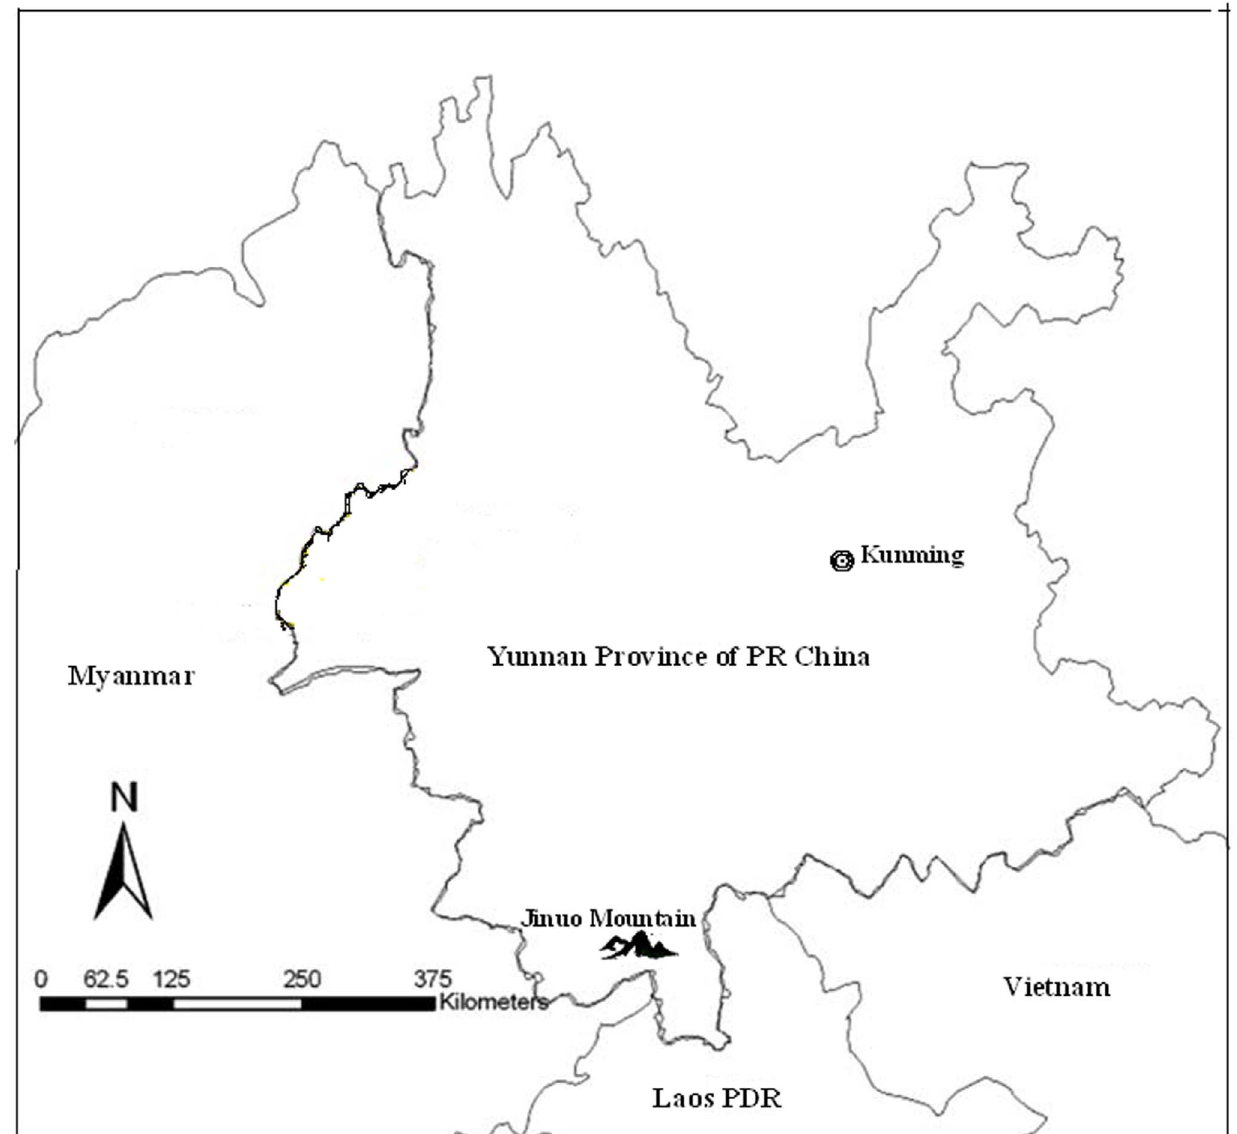
Figure 1. The study site: Jinuo Mountain, Yunnan Province, China.